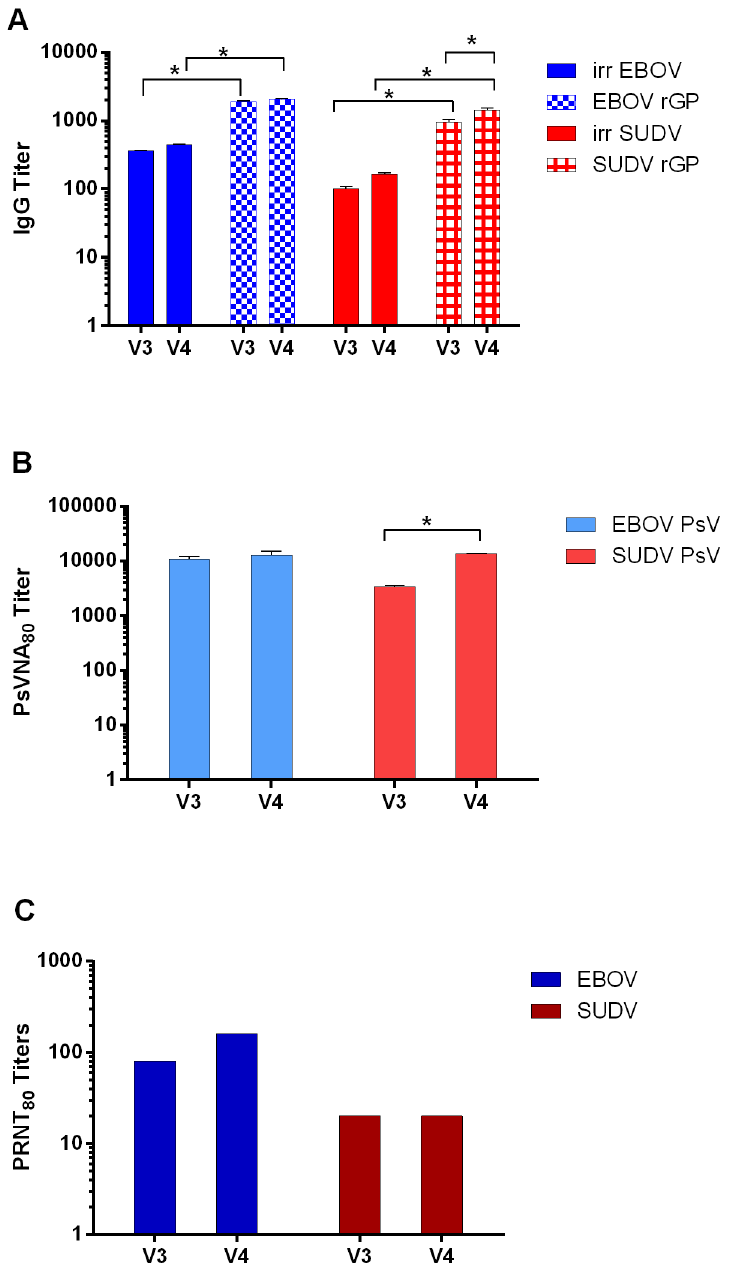
Fig 2. Purified pAbs from vaccinated TcBs demonstrate neutralizing activity against EBOV and SUDV. Antibodies were purified from plasma collected from both TcBs eight days following the third and fourth vaccinations. (A) These purified V3 (22.16 mg/ml) and V4 (36.68 mg/ml) EBOV/SUDV human pAbs were evaluated by standard ELISA for total IgG antibody responses using whole-irradiated EBOV or SUDV antigen, and EBOV rGP or SUDV rGP antigen. (B) EBOV- and SUDV- neutralizing activity of the purified EBOV/SUDV human pAbs was determined by PsVNA, (C) and PRNT. Significant differences between titers are denoted by ( * ) where p <